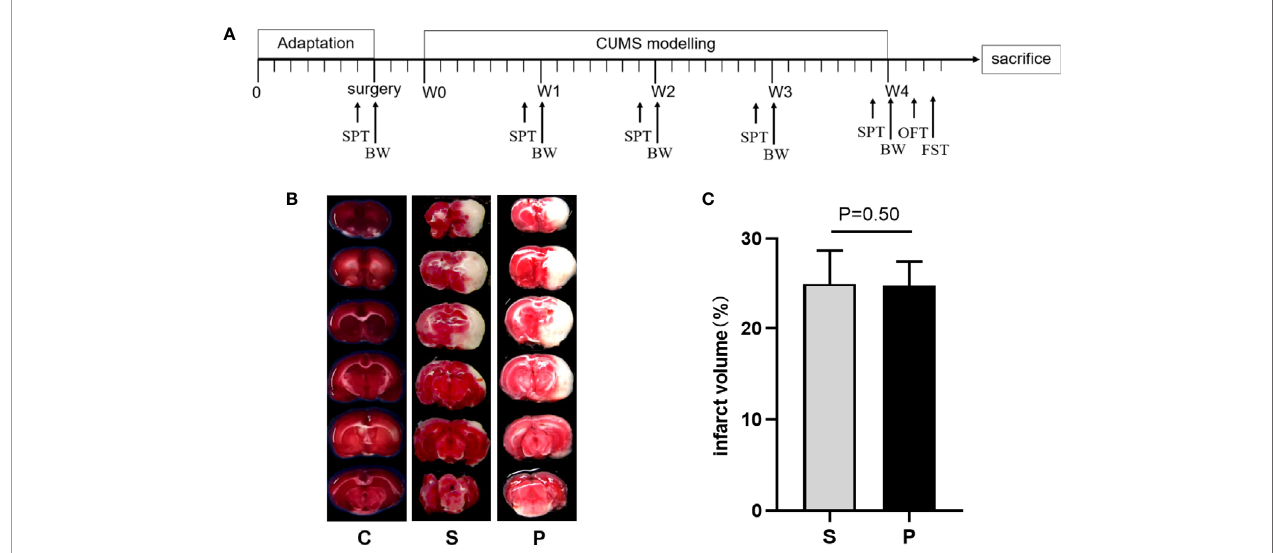
FIGURE 1 | Time schedule of experimental procedures and TTC-stained brain sections. (A) Time schedule of experimental procedures. CUMS, chronic unpredictable mild stress; W0, Beginning of CUMS; W1 – W4, CUMS was performed as described in the materials and methods section for 4 weeks; BW, body weight; SPT, sucrose preference test; OFT, open fi eld test; FST, forced swimming test. (B) The representative TTC-stained brain sections. (C) Quanti fi cation of infarction volumes was calculated based on TTC staining (n = 6 per group, P > 0.05). C, Control; S, Stroke; P, post-stroke